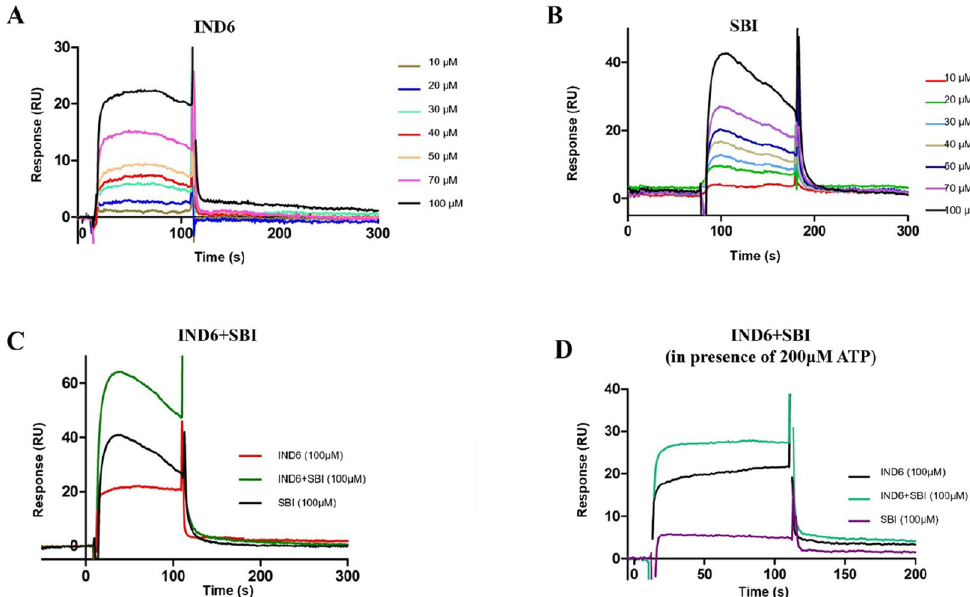
Figure 2. Typical sets of SPR binding curves for the interaction of AMPKα1β1γ1 with ( A ) IND6, ( B ) SBI-0206965, ( C ) SBI-0206965 plus IND6, and ( D ) SBI-0206965 plus IND6 in presence of ATP (200 µM). Experiments were performed increasing the ligand concentration from 10 to 100 μM ( A , B ) or at 100 μM for competitive experiments ( C , D ). The concentration series of ligand solutions were injected over the surfaces in duplicate or